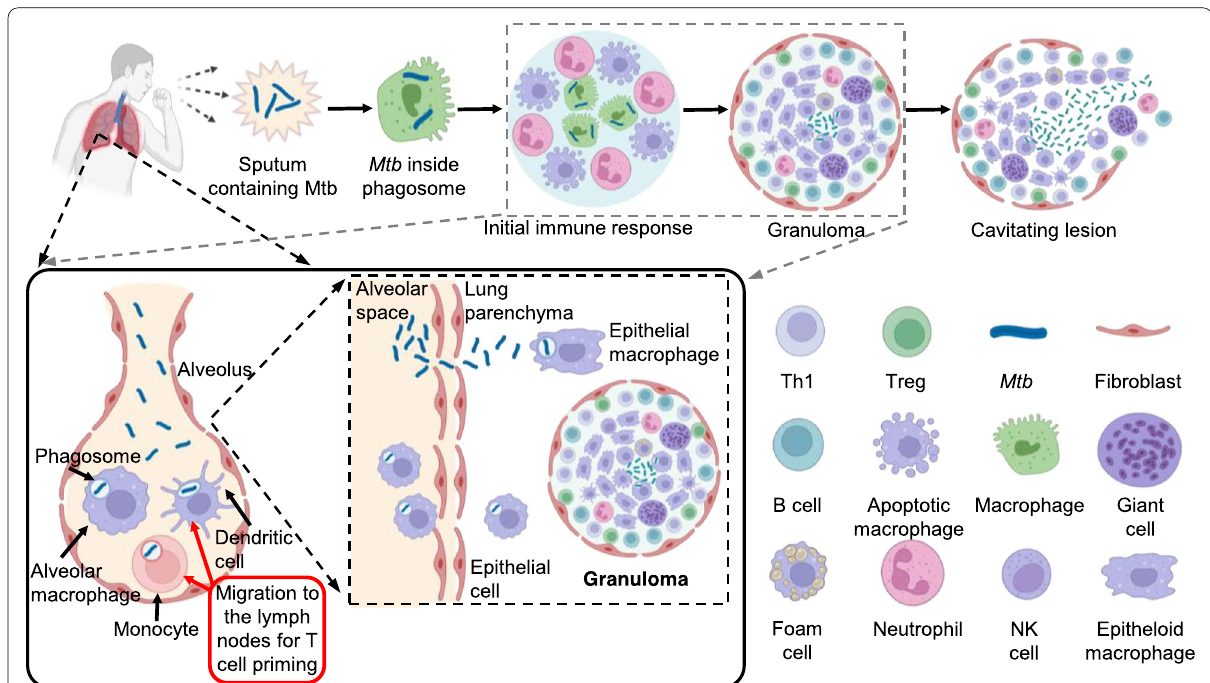
Fig. 1 Pathogenesis of Mycobacterium tuberculosis . Infection begins when Mtb from aerosols or sputum undergoes phagocytosis in the lung reaching tissue-resident alveolar macrophages and dendritic cells. Mtb then undergoes a transient period of unrestricted intracellular replication, during which infected cells migrate to local draining lymph nodes. Once there, Mtb can infect other areas of the lungs by infecting other host cells. With the onset of cellular immunity, a local proinflammatory response leads to the recruitment of additional monocytes and lymphocytes, which in turn cluster around the infected macrophages, forming what is known as a granuloma. Granuloma is a pathological hallmark of tuberculosis, and it is thought that Mtb persists in a prolonged state of delayed or arrested replication at this site. If Mtb multiplies too much, the granuloma will not be able to control the infection and Mtb will eventually spread to other organs, including the brain. At this stage, Mtb can enter the bloodstream or re- enter the respiratory tract to be released causing new infections. The elements in the figure were drawn using biorender online tool (https:// biore nder.